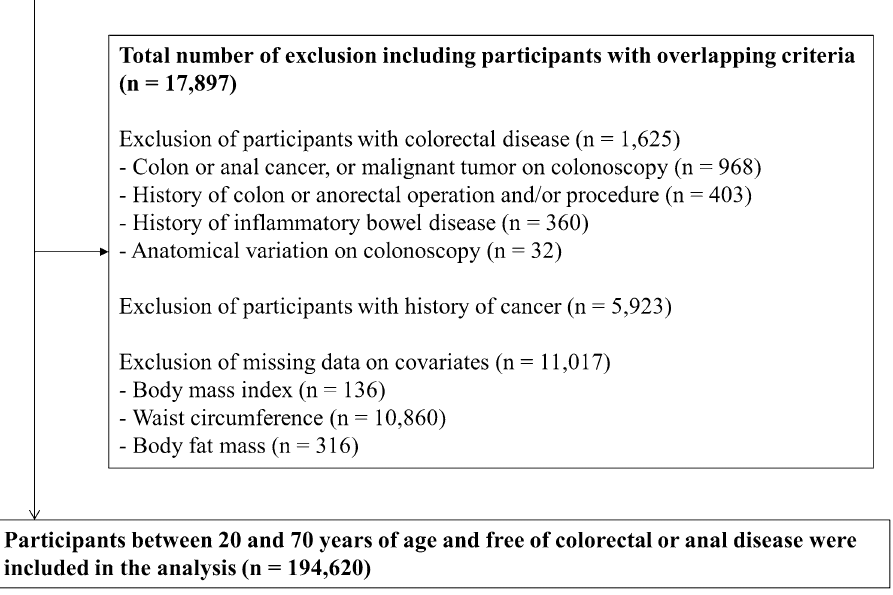
Figure 1. Flowchart of study